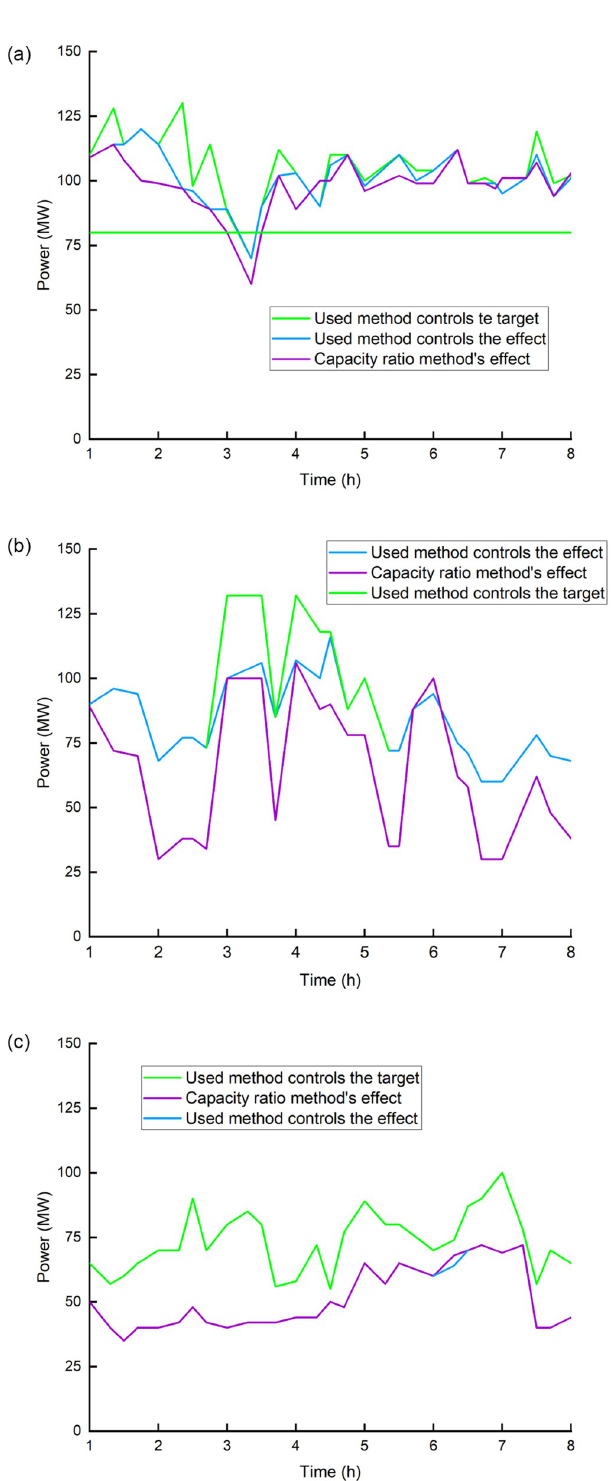
Fig 6. Target and actual value of active power control of each wind farm using proposed method.